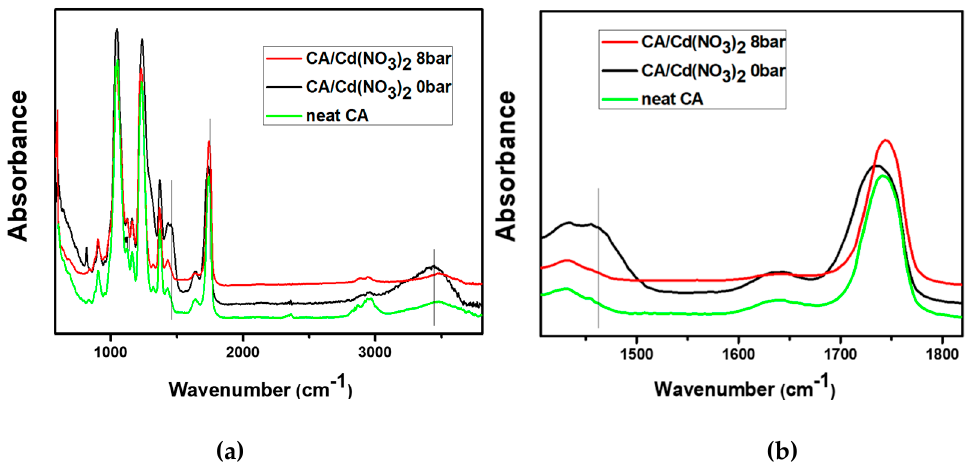
Figure 3. FT-IR spectra of neat CA and 1 / 0.35 CA / Cd(NO 3 ) 2 · 4H 2 O polymer matrix at 0 bar and 8 bar water pressures: ( a ) total range and ( b ) enlarged specific region.